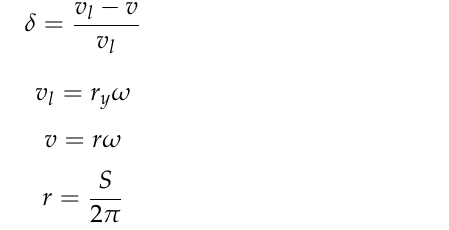
Figure 4. Structure drawing of weeding shovel. 1. Weeding board 2. Connection hole 3. Adjustment hole 4. Support bar 5. Ear plate 6. Spring 7. Mounting hole.